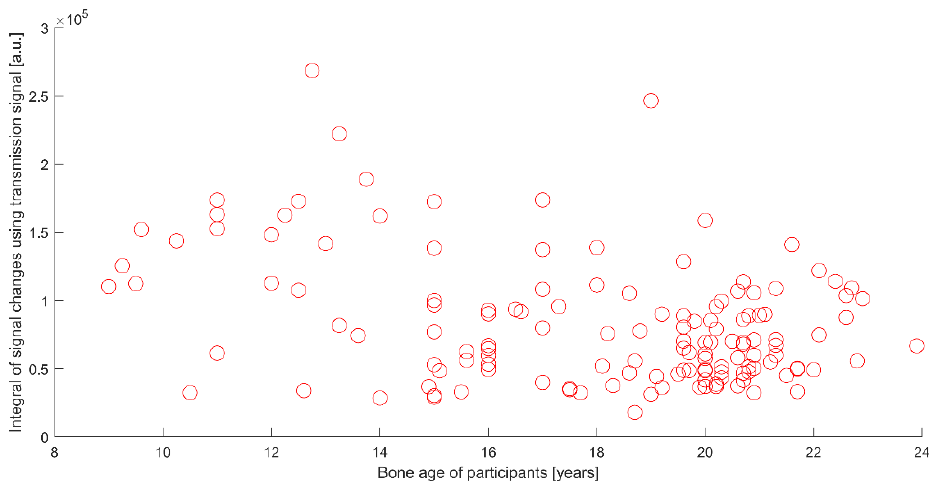
Figure 10. Plot of integral values of transmission signal changes during motor ‐ based transducer